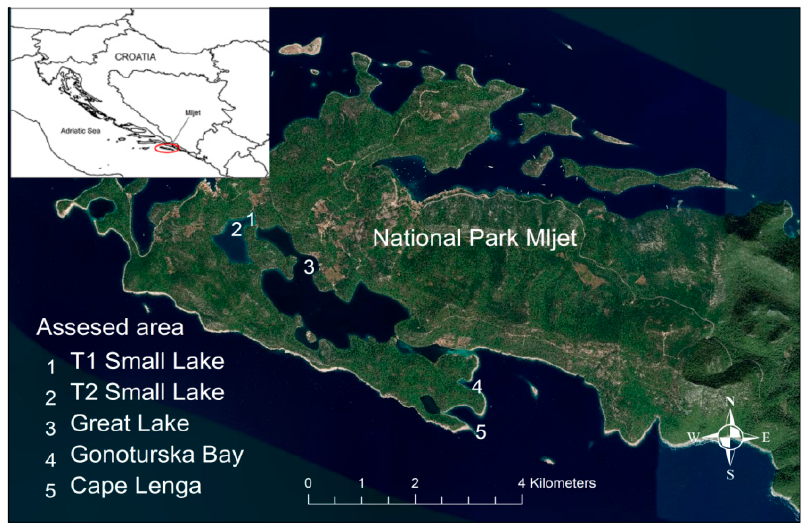
Figure 2. Study site within the Mljet National Park with five sampling points and two transect areas.